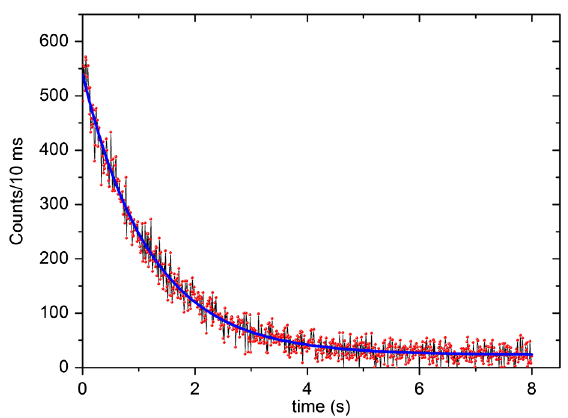
FIG. 13. Decay of 8 Li (setup without the collection device). χ 2 =n ¼ T ¼ 826 ms in comparison with T 1 = 2 in literature adopted